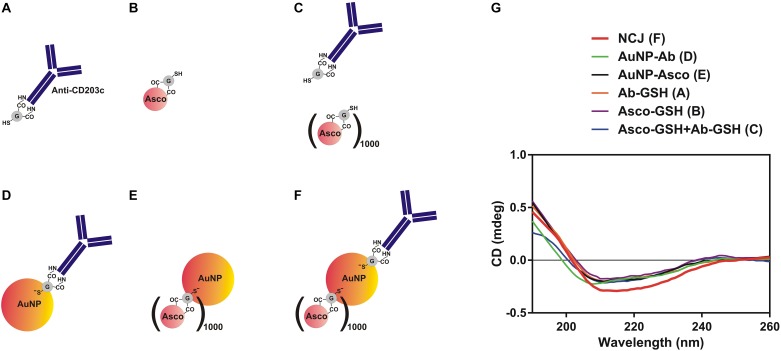
Characterization of nanoconjugates using synchrotron radiation circular dichroism (SRCD) spectroscopy. (A–F) Nanomaterials and compounds which were analyzed using SRCD spectroscopy. (G) Observed far-UV spectra of anti-CD203c antibody, ascomycin and all possible types of functionalised gold nanoparticles. Data are the mean values of four independent experiments.